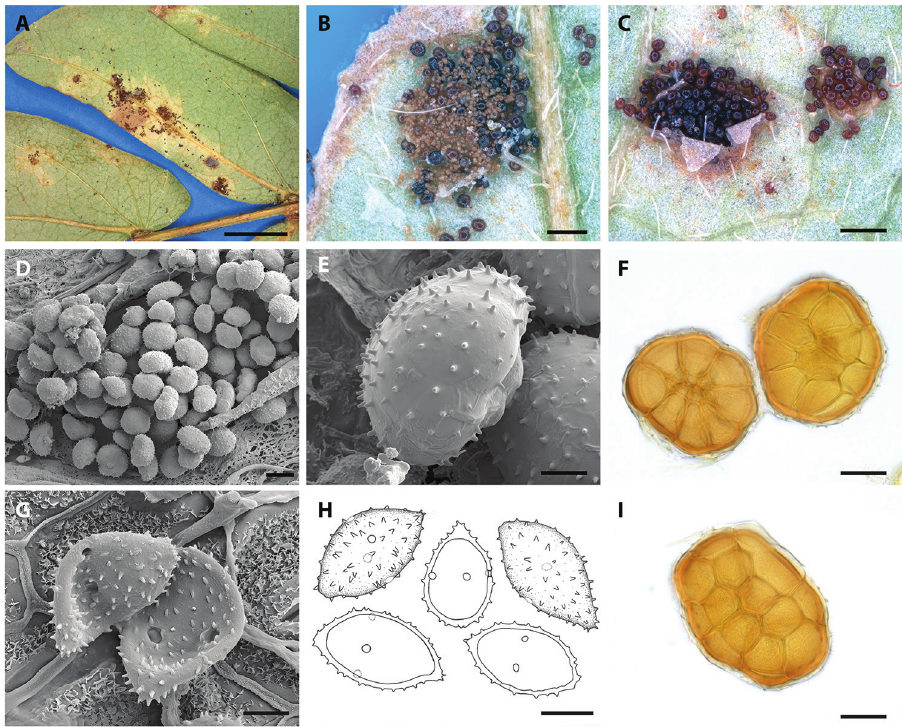
Figure 2. Ravenelia piepenbringiae . A Telia in chlorotic spots associated with infection of Senegalia hayesii B, C sori showing uredinio- and teliospores and teliospores, respectively D SEM image of a telium E SEM view of a teliospore F, I LM images of teliospores G SEM image of urediniospores showing equatorially arranged germ pores H drawings of urediniospores. Scale bars: 3 mm ( A ); 0.1 mm ( B ); 0.2 mm ( C ); 40 mm( D ); 10 mm ( E ); 20 mm( F ); 5 mm( G ); 10 mm( H ); 20 mm( I